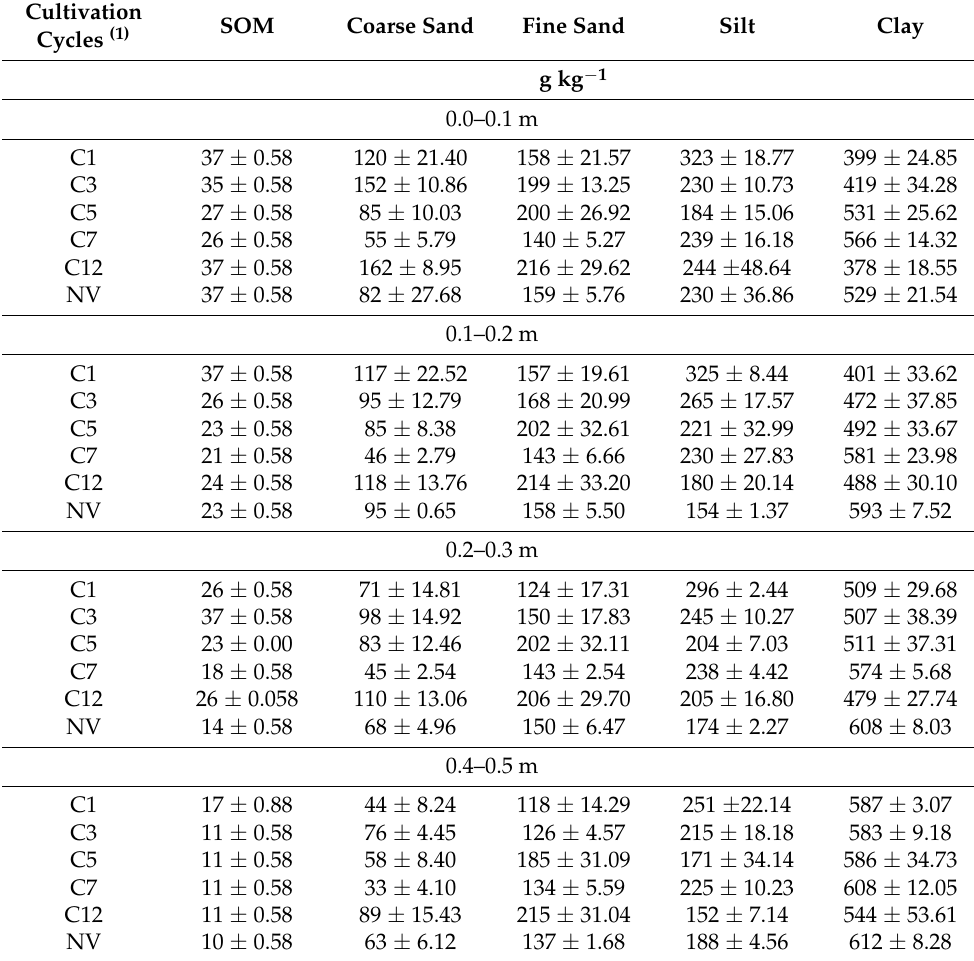
Table 2. Soil organic matter (SOM) and granulometric characterization of Ferralsol areas in sugarcane production environments and native vegetation (NV), in the midwest region of